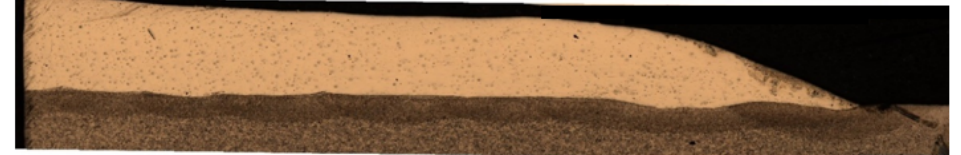
Figure 6. Macrostructure of ALLOY 33 coating cladded on 16Mo3 steel tube, average thickness 2.1 mm (×25).